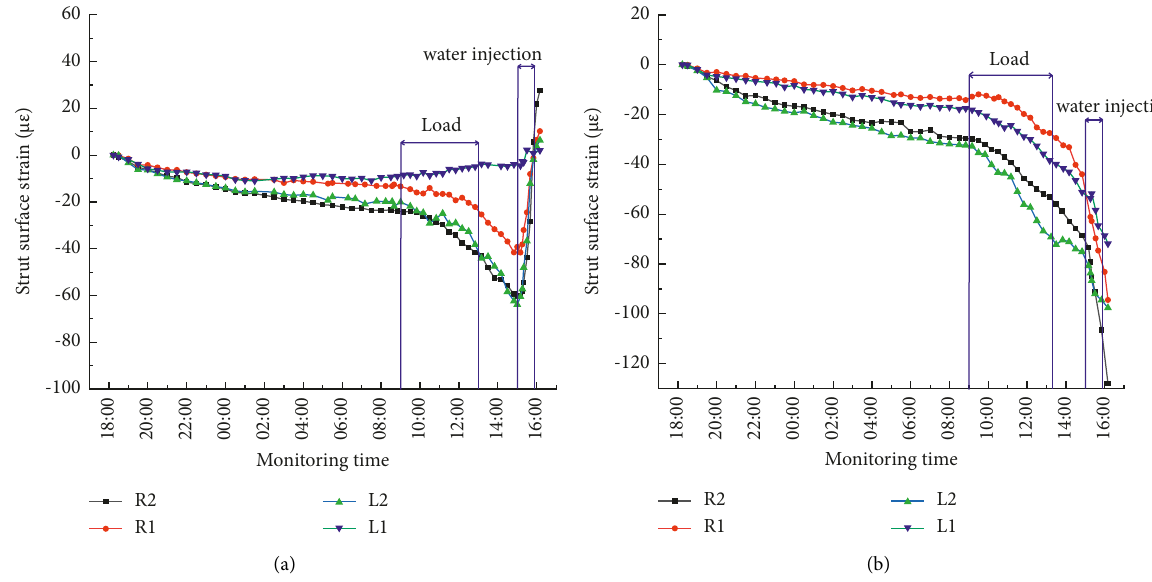
Figure 13: Strain curve of steel strut with time. (a) Surface strain of first layer strut. (b) Surface strain of second layer strut.